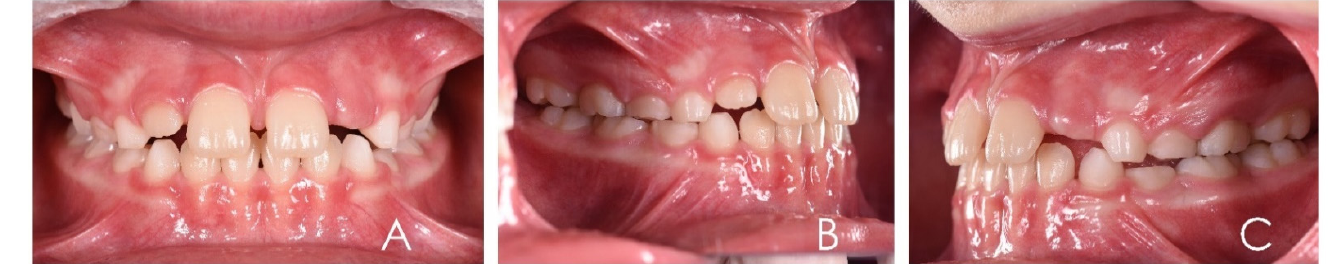
Figure 16. Intraoral photograph of the patient wearing the AMCOP TC.